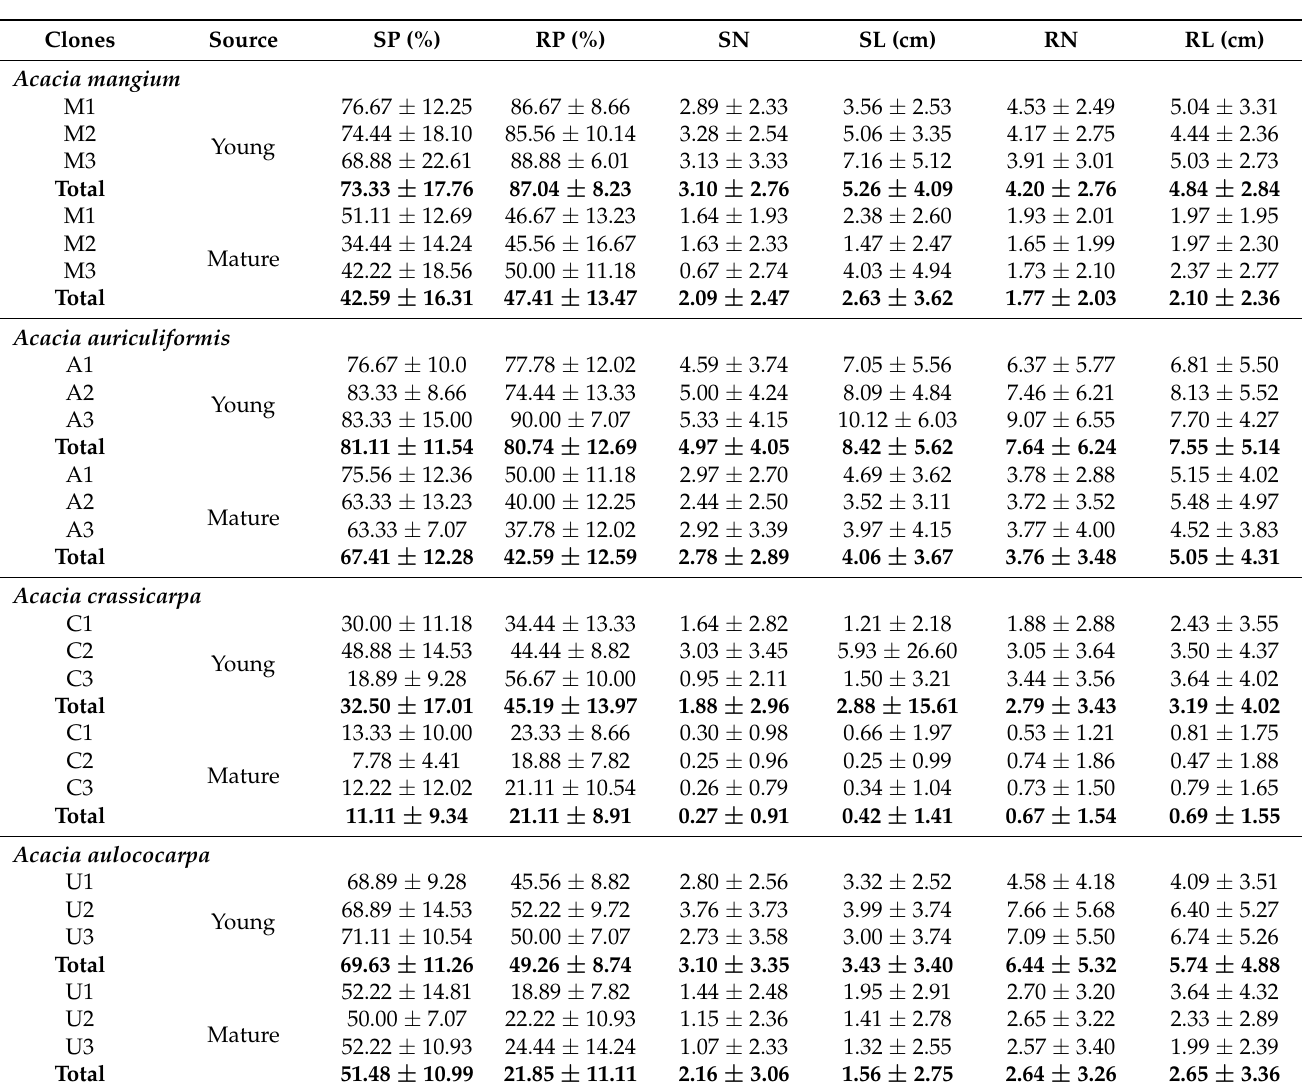
Table 6. Mean values of some rooting ability traits of cutting sources (young and mature) of four Acacia